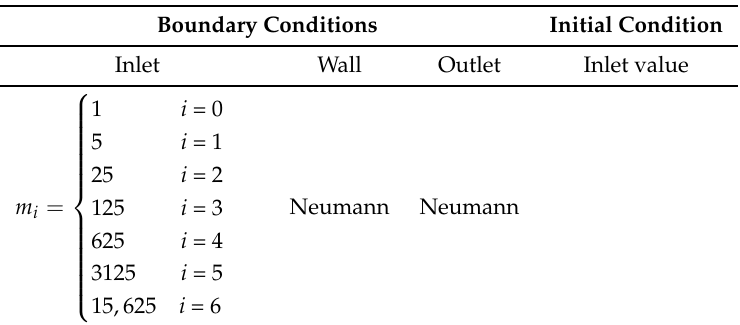
Table 11. Boundary and initial conditions for m i equations used in the QMOM and EQMOM methods (Test Cases I and II).